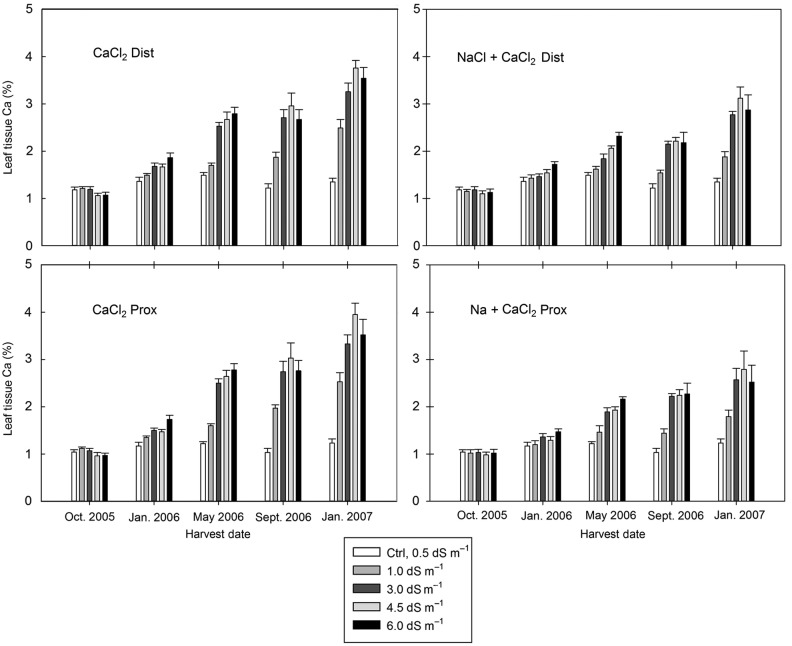
Calcium ion concentration in the leaf tissues followed the same pattern as Na+ and Cl−, with similar concentrations being found in distal and proximal segments and the greatest concentrations being relative to the treatment concentrations, which increased with exposure over time. The final concentrations of Ca+ ions found in the leaf tissues in January 2007 were >2 % for all Ca+ containing salt treatments. Conversely, no treatment had >2 % Cl−, and only the 6.0 NaCl treatments had >2 % Na.